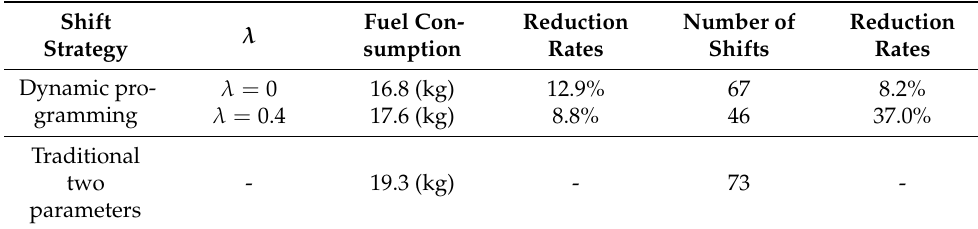
Figure 9. The simulation results of the optimized shift strategy based on the DP. ( a ) Engine speed, ( b ) engine torque, ( c ) the AT gear selected, and ( d ) vehicle fuel consumption. Table 3. Comparison results of shift strategy based on the dynamic programming with the traditional two parameters.